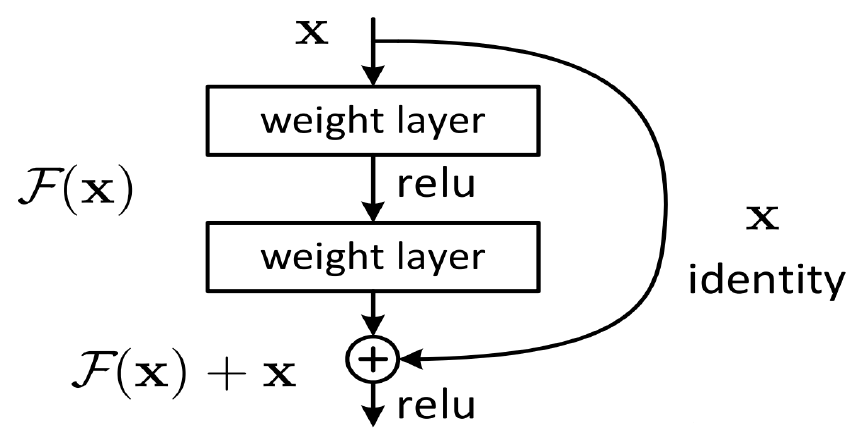
Figure 6. The key structure of